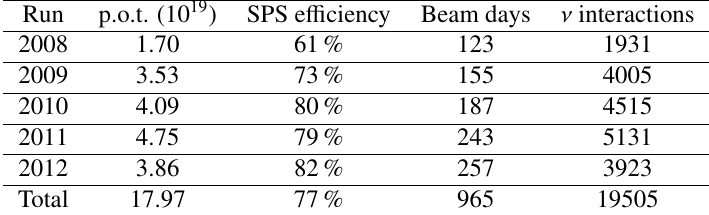
Table 1. CNGS beam performance. For each physics run, the number of neutrino interactions in the target is also